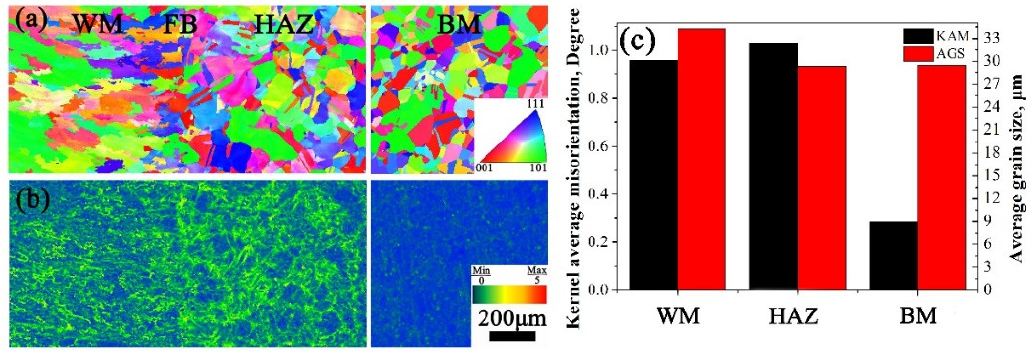
Figure 7. ( a ) Inverse pole figure (IPF), ( b ) kernel average misorientation (KAM) maps, and ( c ) statistical information in different section of the 308L-316L welded joint.